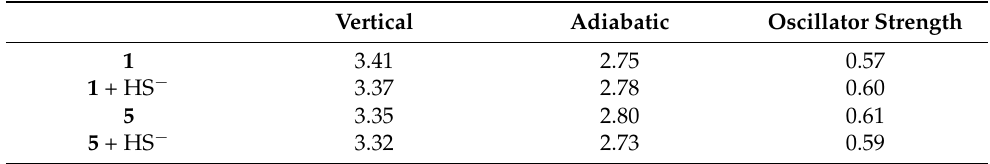
Table 1. Computed vertical and adiabatic excitation energies (eV) and oscillator strength for the S 1 ← S 0